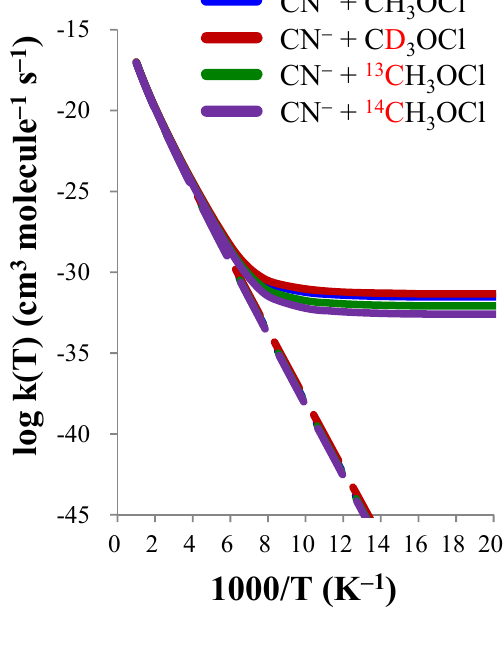
Figure 3. The Arrhenius plots of the calculated rate constants of the gas phase CN − + CH OCl reaction and its three isotopically substituted analogs. The broken and solid lines 3 indicate results obtained at the TST and CVT/SCT levels,